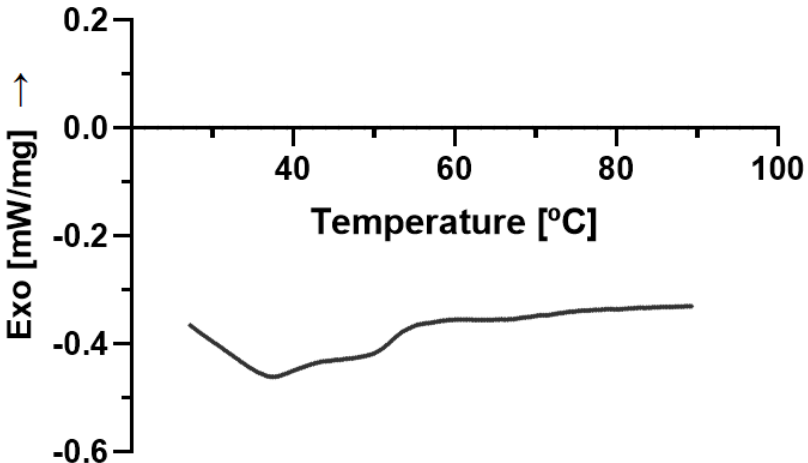
Figure 6. Differential scanning calorimetric profile of bulk CBD, depicting a melting peak at 37.5 °C. Table 5. The lipid nanoparticle dispersions (% w / w ) were composed of Compritol ® 888 ATO (solid lipid) to obtain CBD-cSLN and